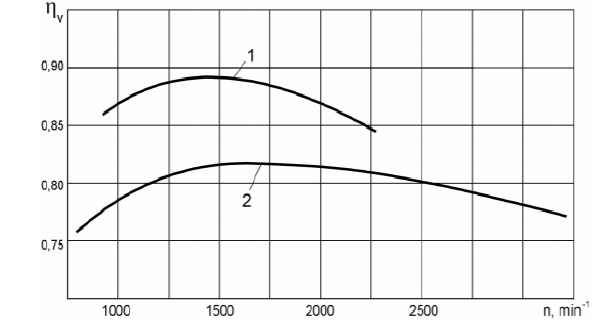
Fig. 1. Dependence of volumetric efficiencyon the cranskshaft velocity for respective types of engines: 1 – self-ignition engine, 2 – spark-ignition engine